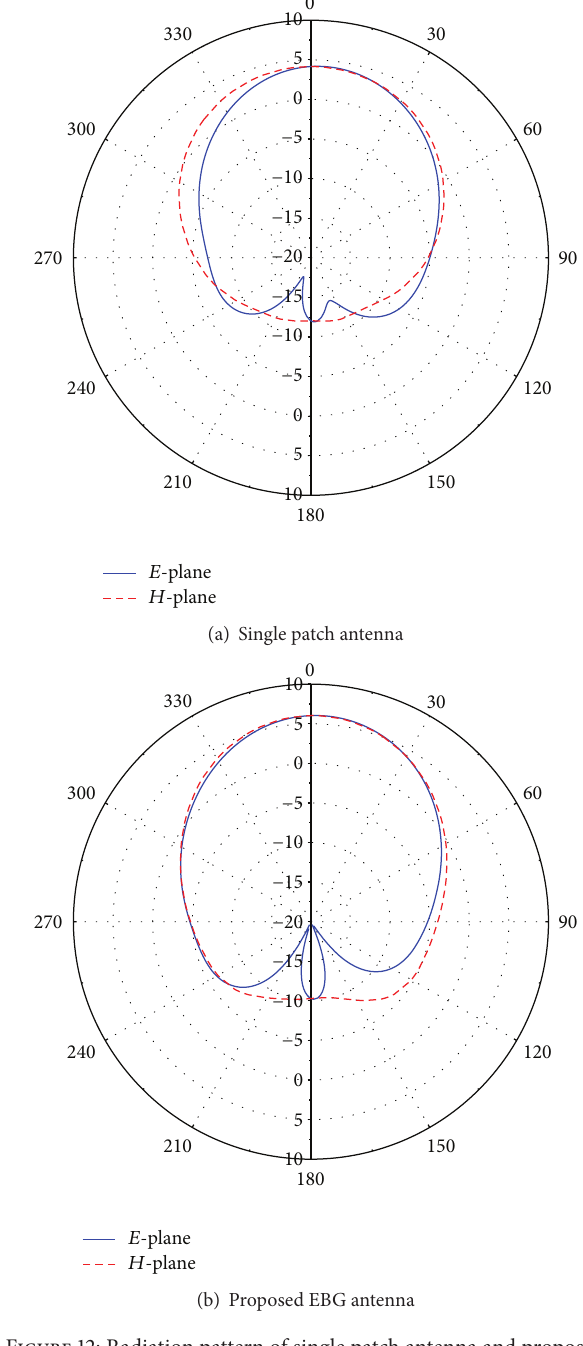
Figure 12: Radiation pattern of single patch antenna and proposed EBG antenna at 4.57